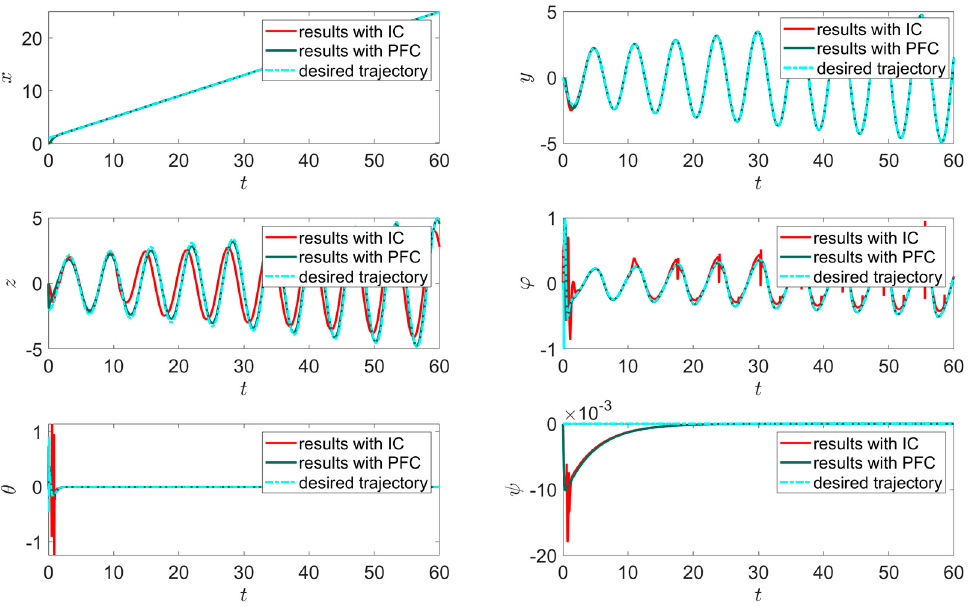
Figure 9. Comparison of system state time history between proposed fractional order controller (PFC) and integer order controller (IC).